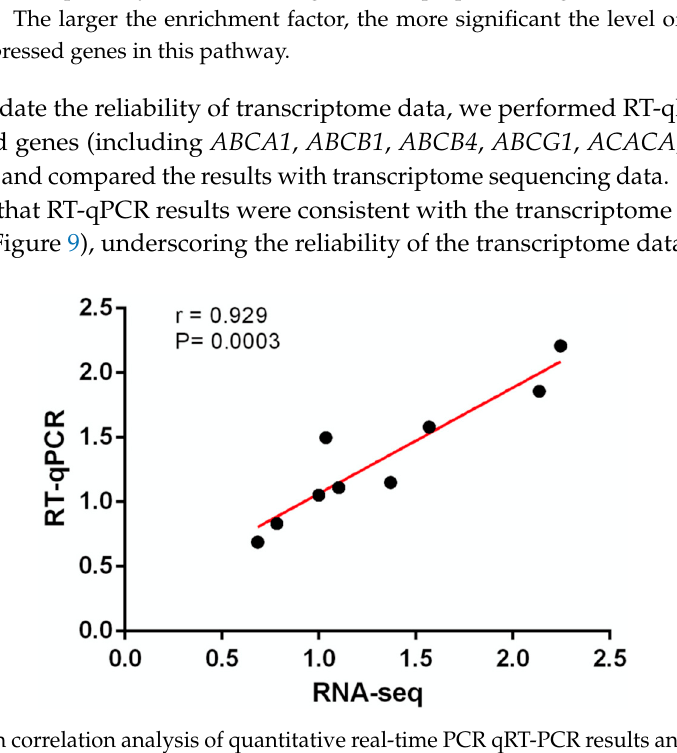
Figure 10. Pearson’s correlations between gene transcription and phenotypic traits. Size of the circle in the figure represents the correlation coefficient. Numbers in the circles represent p -values which are corrected by false discovery rate (FDR). HDL: high density lipoprotein; LDL: low density lipoprotein; TP: total protein; TG: triglycerides; ALB: albumin; LW: liver weight; PFW: perirenal fat weight.